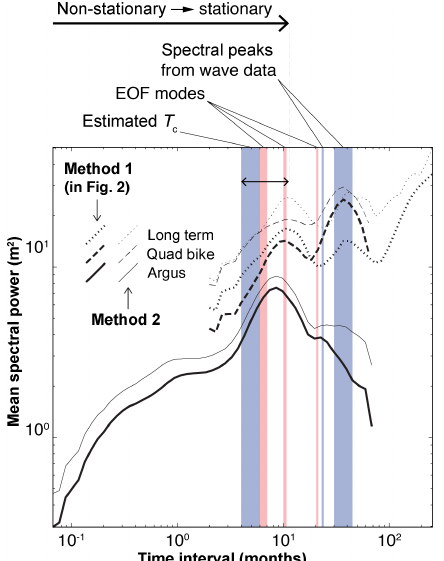
Figure 4. Compilation of power spectra from shoreline-change data in relation to different characteristic timescales for environmental forcing (blue/dark bars) and intrinsic physical processes (red/light bars). Thick black lines indicate power spectra shown in Fig. 2d, derived from the alongshore median absolute value of shoreline change through time (“method 1”). Thin grey lines show the median spectral densities of power spectra of shoreline change through time (detrended, absolute value) at each position alongshore for the three survey types (“method 2”), shown in Fig. S1. We plot them together here to demonstrate their comparability. Double-ended arrow indi- cates transition zone in the spectral density from non-stationary to stationary by a temporal interval on the order of ∼ 10 1 months.